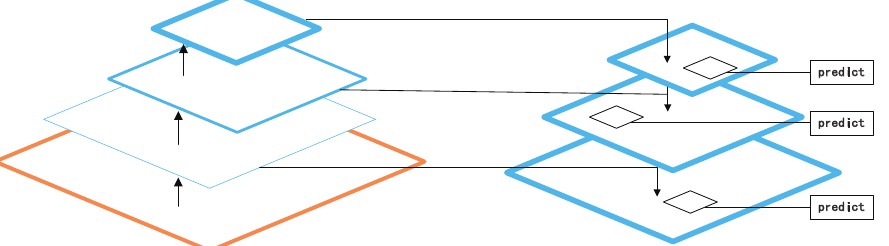
Figure 7. Feature pyramid fusion structure diagram. The horizontal connection of the feature pyramid is added to fuse the information of the shallow feature map and the deep feature map.